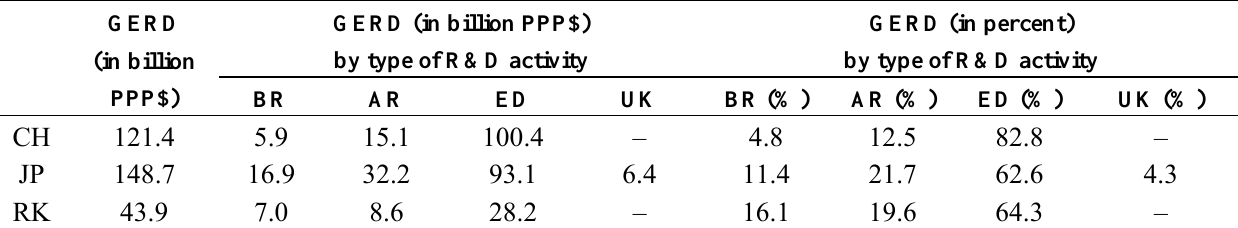
Table 3. R&D expenditure type and its four components: Basic research (BR), Applied research (AR), Experimental development (ED) and Unknown (UK) in China, Japan and Korea